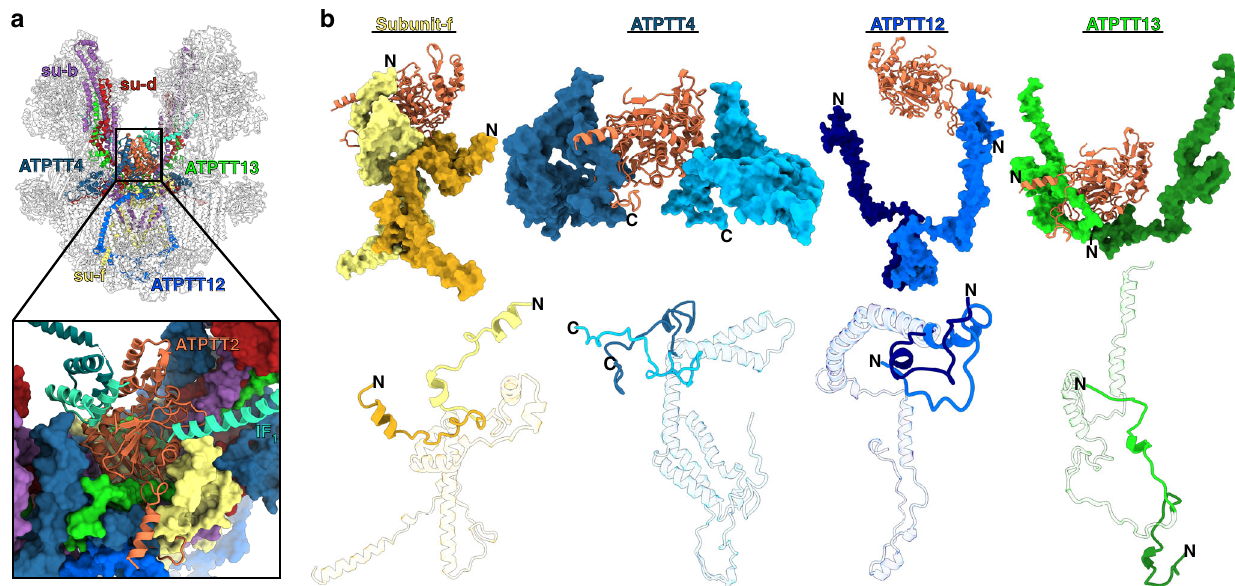
Fig. 2 The binding of ATPTT2 results in a symmetry-deviated ATP synthase. a Overview showing the location of the substoichiometric ATPTT2 with its interacting subunits. Close-up view shows the cradle-shaped ATPTT2 binding site (colored surfaces). b Symmetry-deviated subunits in respect to ATPTT2. Lower panel: superpositions of subunit from the two monomers features the